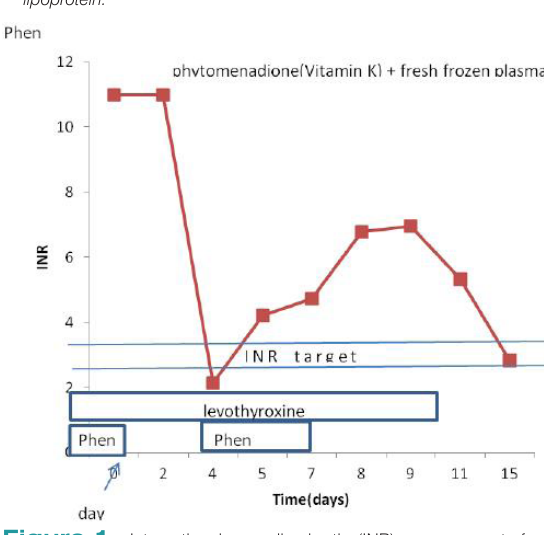
Figure 1. International normalized ratio (INR) measurements from time of admission until hospital discharge for a 62-year- old female patient experiencing a suspected interaction between phenprocoumon (Phen) and levothyroxine. Boxes indicate days on which the respective drugs were